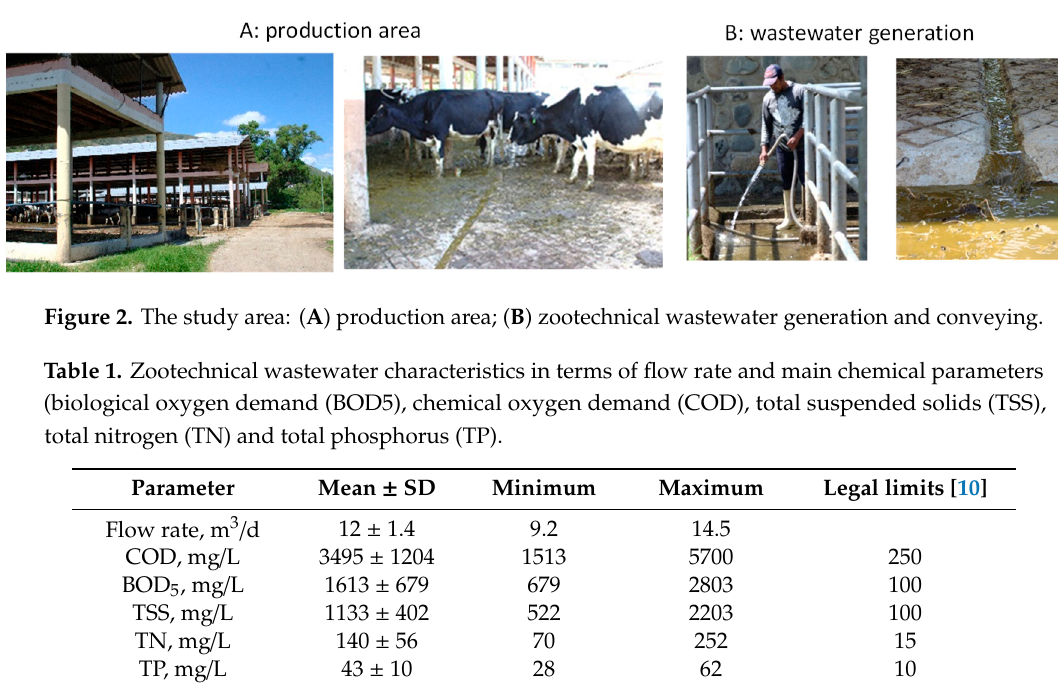
Table 1. Zootechnical wastewater characteristics in terms of flow rate and main chemical parameters (biological oxygen demand (BOD5), chemical oxygen demand (COD), total suspended solids (TSS), total nitrogen (TN) and total phosphorus (TP).